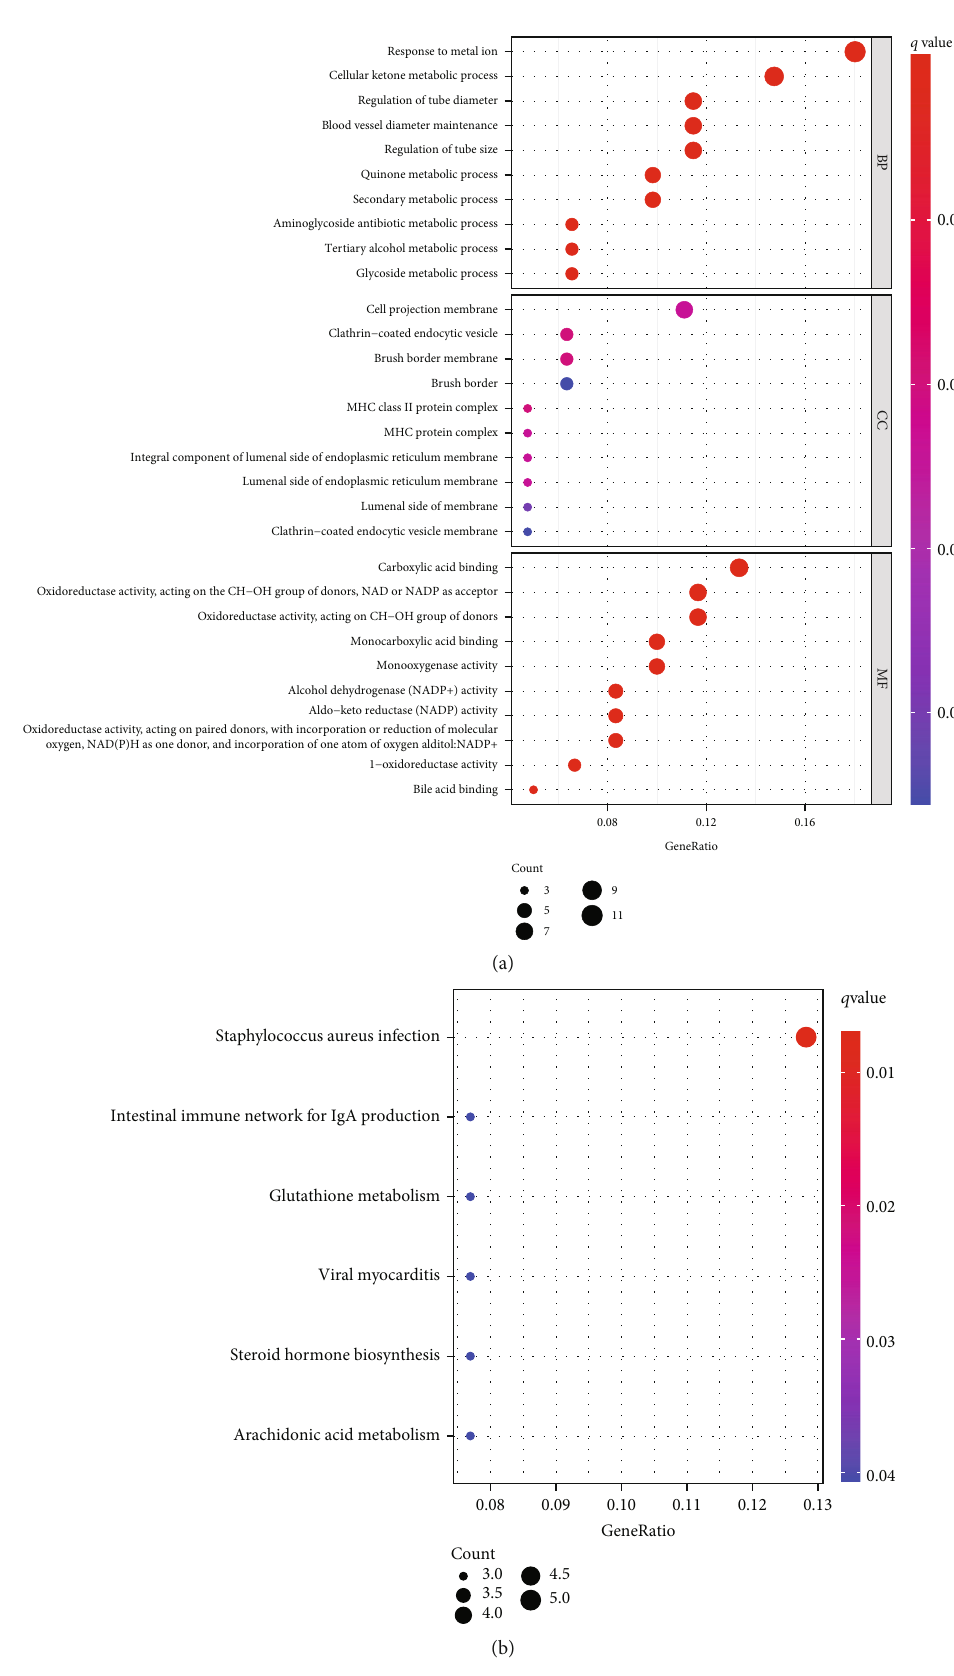
Figure 10: (a) GO analyses and (b) biological pathway enrichment analyses of the dysregulated